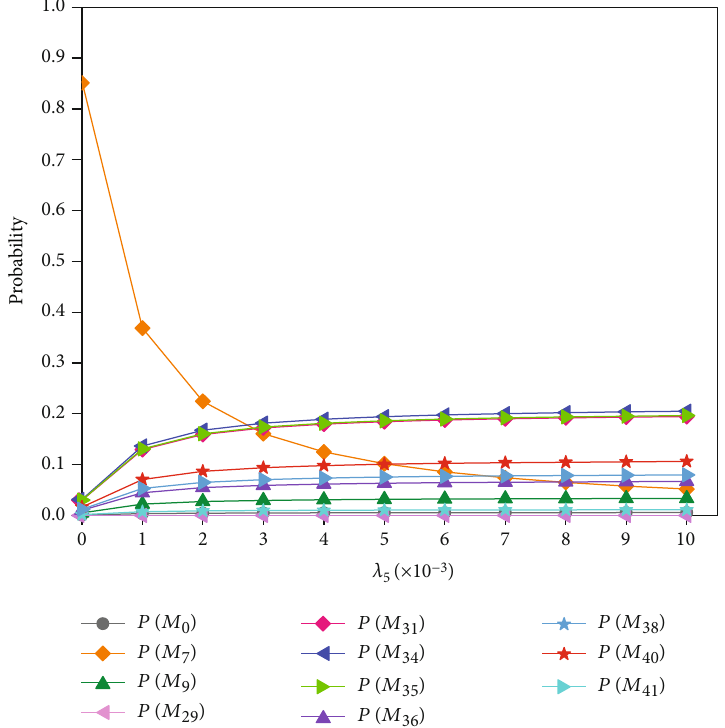
Figure 12: Variation of system probability with change in λ